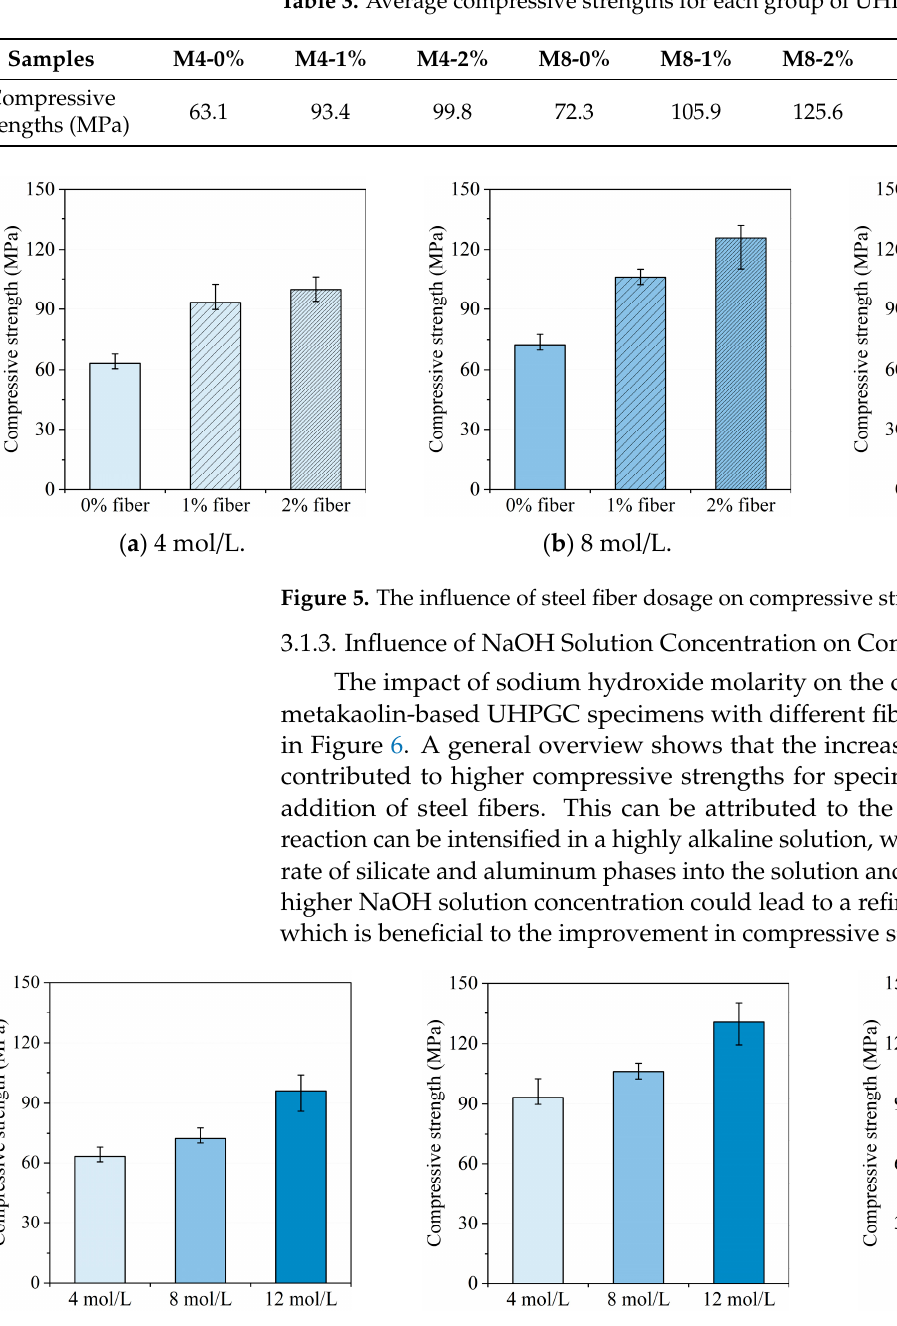
Table 3. Average compressive strengths for each group of UHPGC.